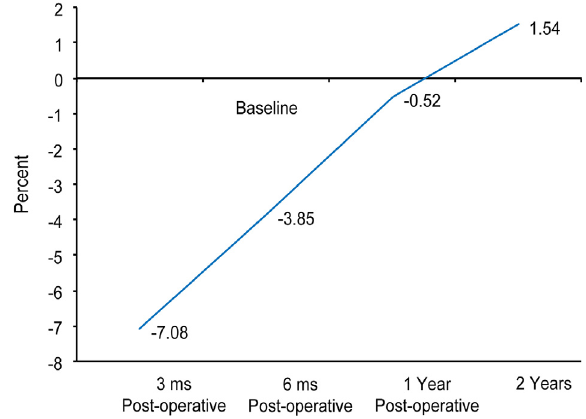
Figure 3. Graph showing the net changes in the BMD over a span of 2